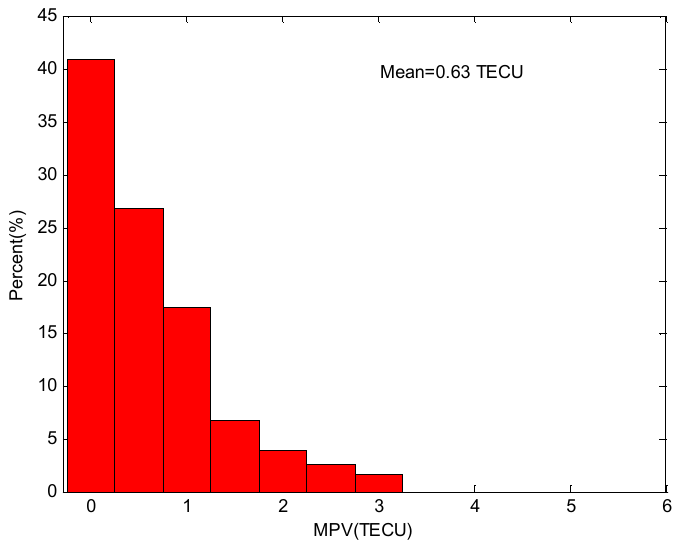
Figure 5. Percent distribution of the maximum positive value (MPV) by the station HKKT during 2014.